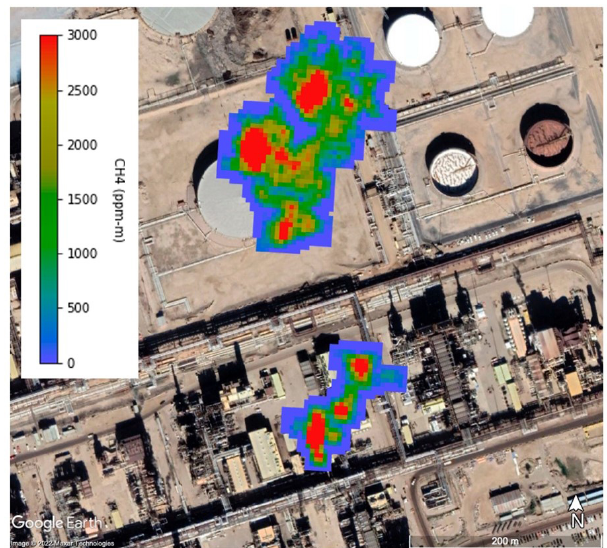
Figure 9. AVIRIS-NG observed CH 4 enhancements were imaged at the Syncrude plant site on 21:17:24UTC. There appear to be two distinct sources located in close proximity. Satellite imagery ©2020 Maxar Technologies, Google